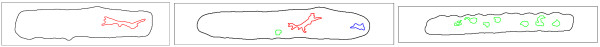
Automatically generated sketches of the cell images of Figure 4. The cell boundary appears in black. Objects classified as haustoria are marked in red, other objects in green, ambiguous objects in blue.